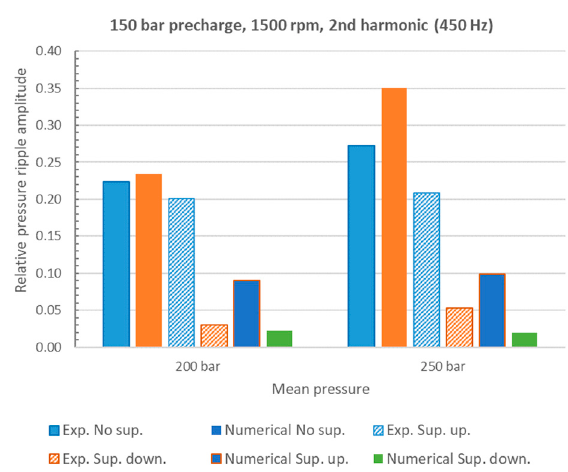
Figure 9. FFT of the pressure ripple, 1st harmonic, pump speed = 1500 rpm.